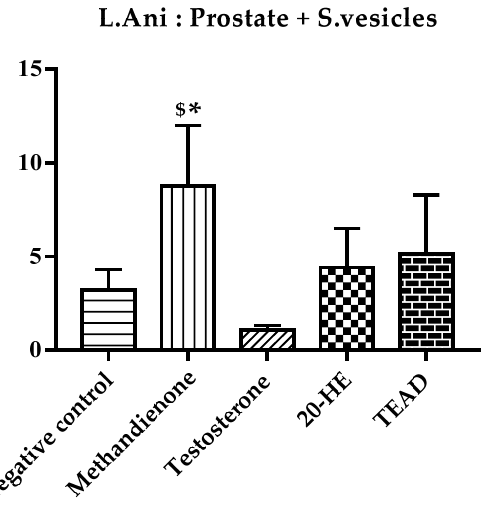
Figure 11. Average levator ani muscle mass to secondary sex organs ratio. *: Significantly different from the negative control group at p = 0.01. $ : Significantly different from the testosterone group at p = 0.0005.